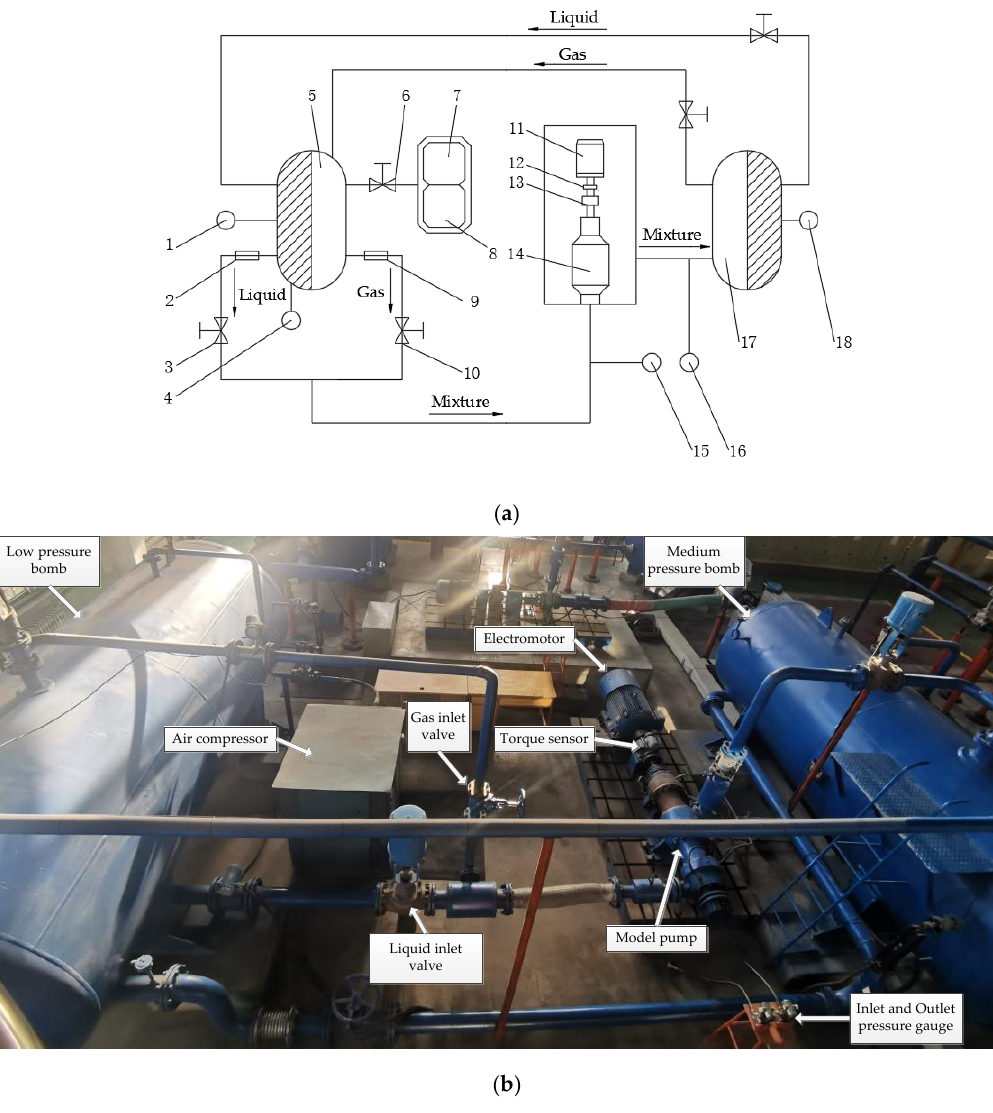
Figure 3. Gas–liquid two-phase flow pump performance test bench. ( a ) The schematic diagram Figure 3. Gas – liquid two-phase flow pump performance test bench. ( a ) The schematic diagram of the of the gas–liquid two-phase flow pump performance test bench. 1,4,15,16,18—Pressure gauge; gas – liquid two-phase flow pump performance test bench. 1,4,15,16,18 — Pressure gauge; 2—Electromagnetic flow meter; 3—Liquid inlet valve; 5—Low pressure bomb; 6—Gas valve;